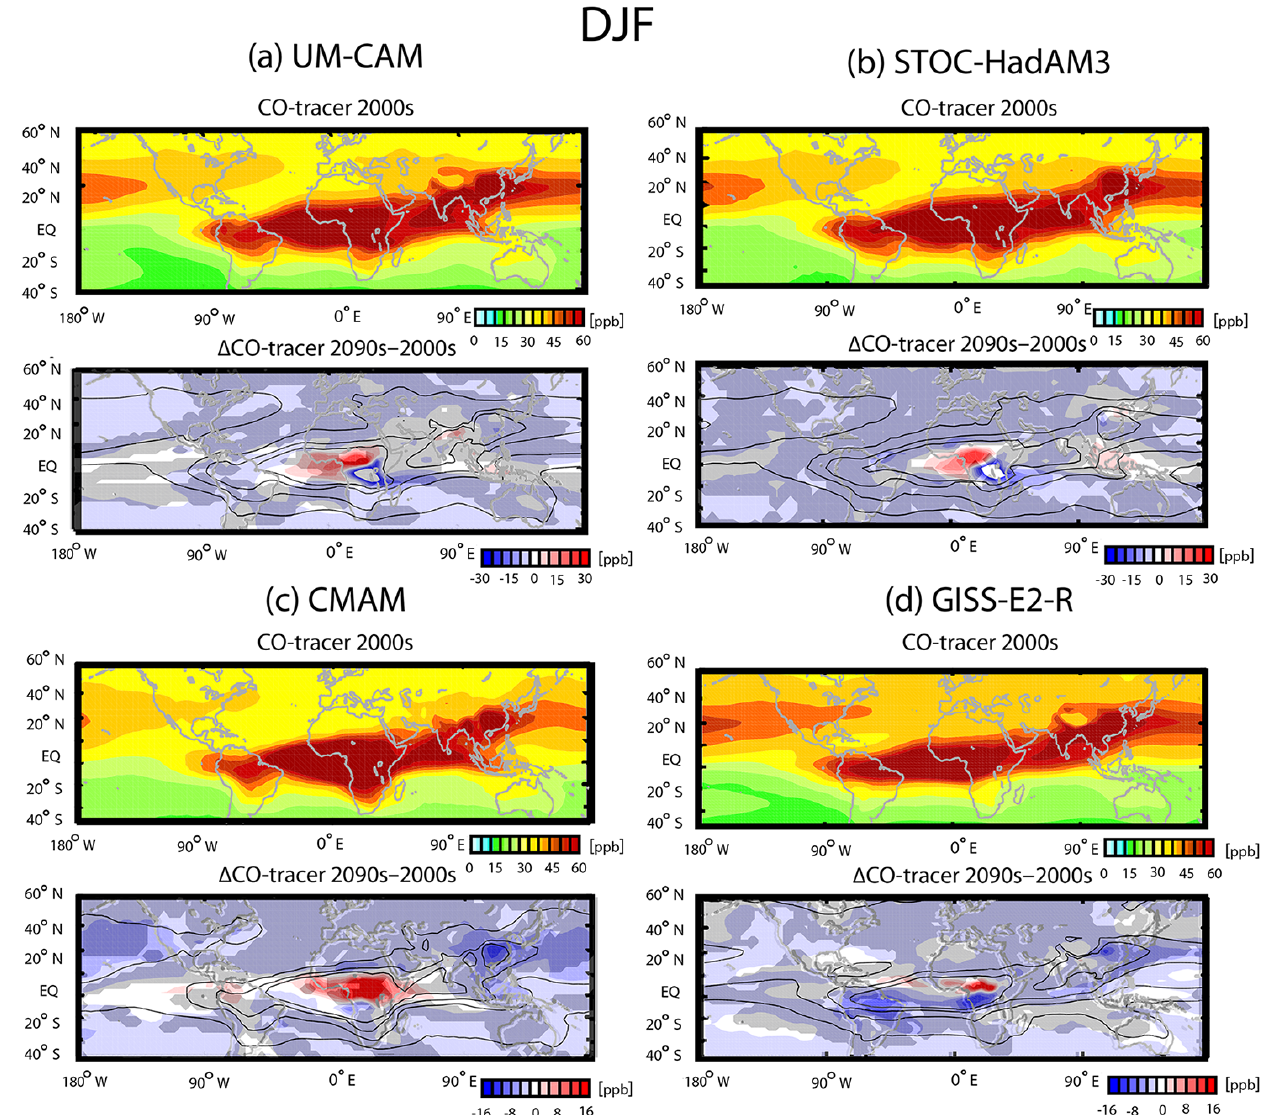
Figure 4. Top panels within subplots (a–d) : present-day (1995–2006) DJF 10-year climatological mean CO-tracer distribution, averaged over 400–800hPa. Bottom panels: differences between 2090–2099 (RCP 8.5) and 1995–2006 (present day) DJF climatological mean CO-tracer distributions, wherein black contours denote the present-day climatology. Results are presented for (a) UM-CAM and (b) STOC-HadAM3 (top panels) as well as (c) CMAM and (d) GISS-E2-R (bottom panels). Grey shading indicates where results are not significant at p < 0 . 05 as evaluated with a Student’s t test using 10 years of data for the 2090s (RCP 8.5) and present-day simulations. Note the different scales